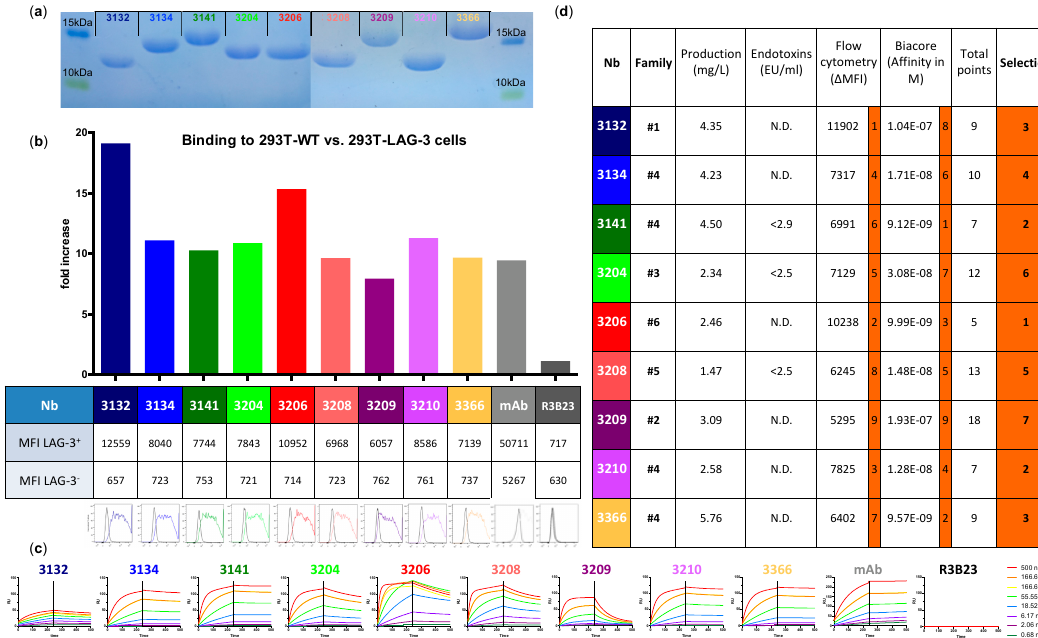
Figure 1 . Characterization of binding and affinity for mouse LAG-3 (moLAG-3) of purified nanobodies (Nbs). ( a ) sodium dodecyl sulfate-polyacrylamide gel electrophoresis (SDS-PAGE) of 20 μ g purified Nb stained with Coomassie blue ( n = 1). ( b ) Binding of 1 μ g of His 6 -tagged Nbs on 293T-wild type (WT) cells versus 293T-moLAG-3 cells ( n = 1). The graph shows the ratio of bound nanobody on 293T-WT versus 293T-LAG-3, while the table shows the mean fluorescence intensities used to calculate the ratio and the flow cytometry histograms show the binding of the nanobody to 293T-WT (black line) and to 293T-LAG-3 (matched colored line) ( n = 1). ( c ) Evaluation of affinity/kinetics of purified Nbs on immobilized recombinant moLAG-3 protein ( n = 2). Each sensogram represents the binding of a 3-fold dilution series (0.68, 2.06, 6.17, 18.5, 55.6, 167, and 500 nM) of the same Nb. ( d ) Summary of Nb characterization. Selection is based on binding capacity to moLAG-3 evaluated by flow cytometry and surface plasmon resonance (SPR)-measured a ffi nity. The columns in orange show a ranking per evaluated criterium and an overall ranking for each Nb